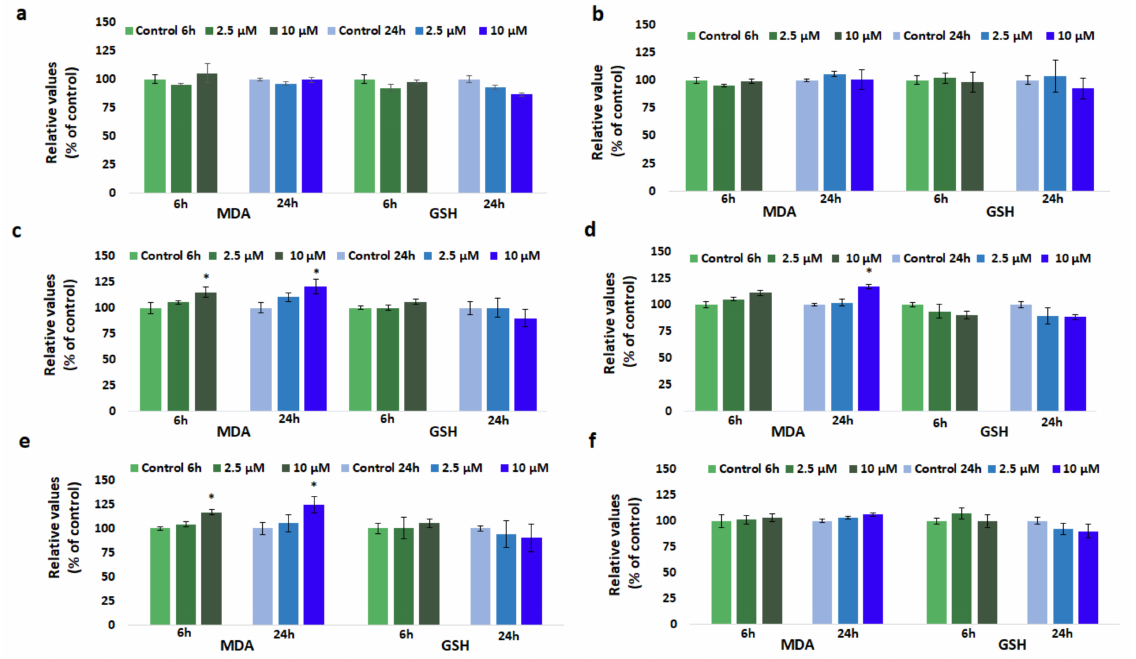
Figure 4. Malondialdehyde (MDA) and glutathione (GSH) relative levels in SVEC4-10 cells in the presence of increased concentrations of ( a ) GdDOTP citric acid, 2.5 mg · mL − 1 CS; ( b ) GdDOTP acetic acid, 2.5 mg · mL − 1 CS; ( c ) GdDOTP citric acid, 1.5 mg · mL − 1 CS ; ( d ) GdDOTP acetic